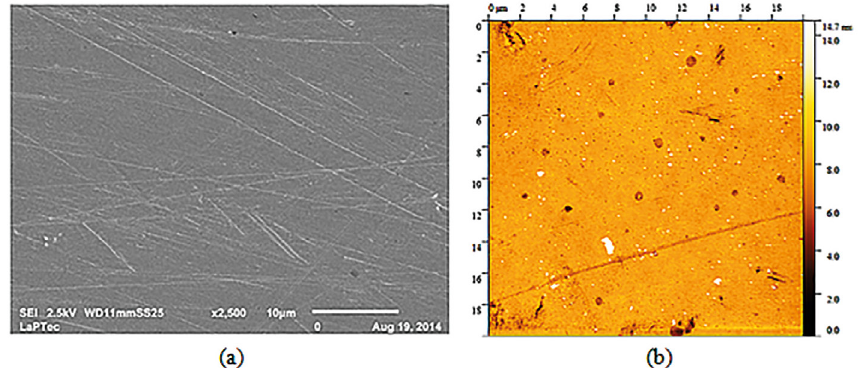
Figure 7. (a) Secondary electron micrograph of the as-received stainless steel. (b) AFM topographic profile for the glass